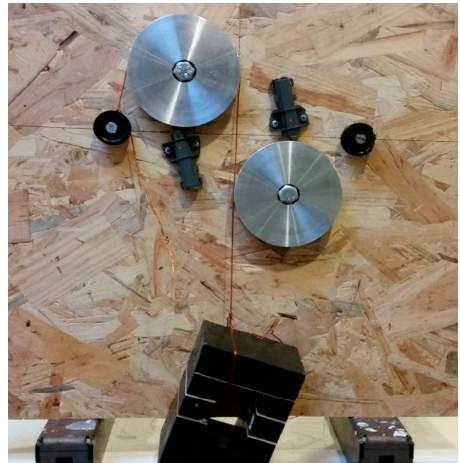
Figure 8. Test bench for the application on a mechanical constraint.